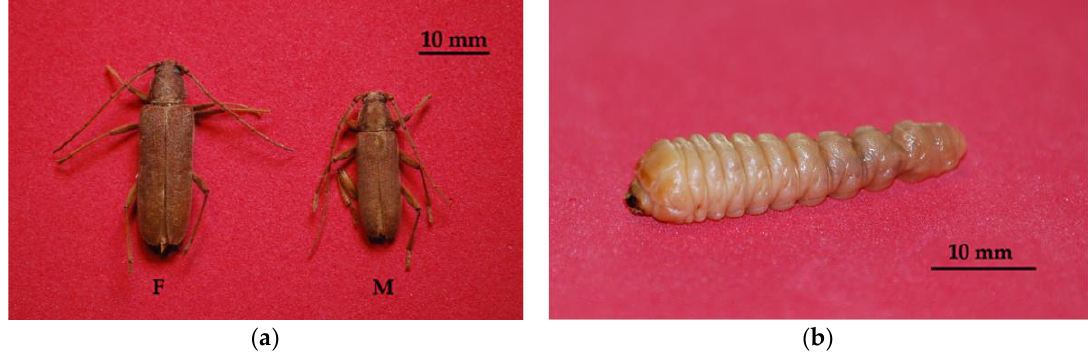
Figure 1. Stromatium unicolor (Olivier, 1795) ( a ) imago (F: female; M: male); ( b ) larvae.